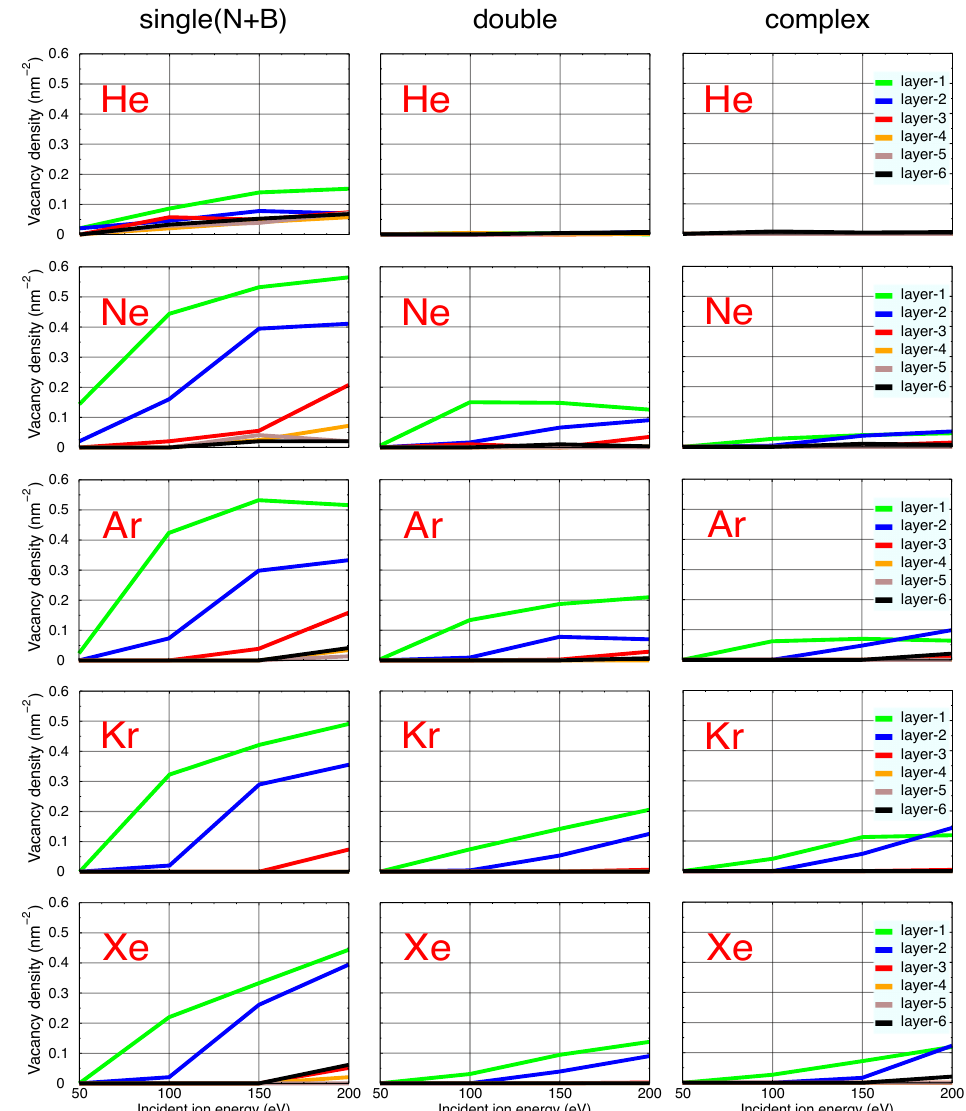
Figure 8. Densities of vacancies created in different layers upon irradiation with various inert gas ions. The rows of plots correspond to projectiles of the same type, while the columns show vacancies of the type. Single (N + B) is the sum of single N and single B vacancies. Different h-BN layers are color-coded. To facilitate the comparison of the effects of different ions, the scale is the same in all the plots.